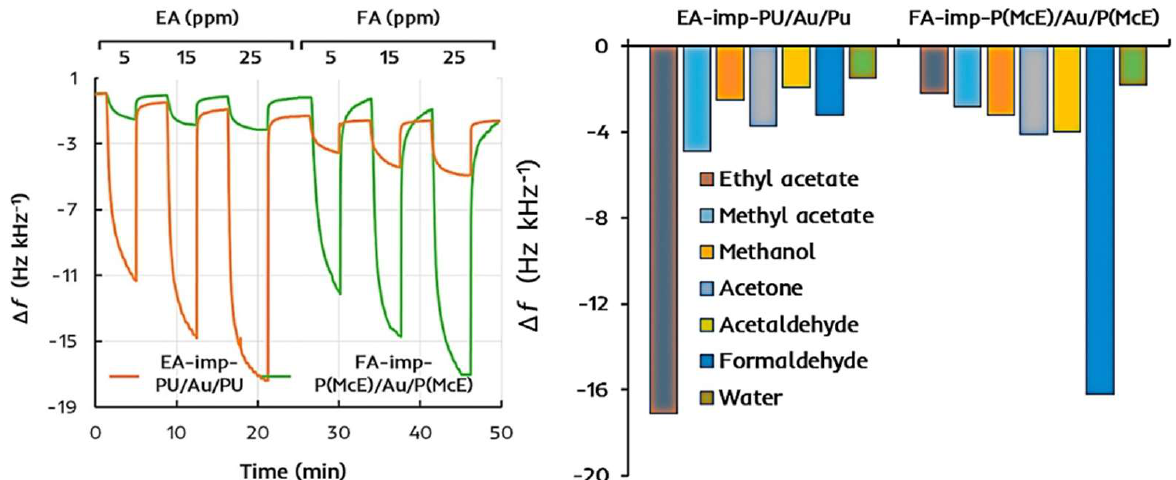
Figure 1. Ethyl acetate (EA) and formaldehyde (FA) imprinted polymers produced by porogen and template imprinting, respectively. The sensors were produced by coating a QCM device with imprinted polymer (polyurethane, PU, or methacrylic acid-co-ethylene glycol dimethacrylate, McE), followed by coating with gold nanoparticles, and finally with a second layer of MIP. The change of resonance frequency ( ∆ f ) was then monitored in the presence of different gaseous compounds in dry air. Studies with interferents (right) were performed with 25 ppm analyte, or 50% relative humidity in the case of water. Reproduced with permission [44].